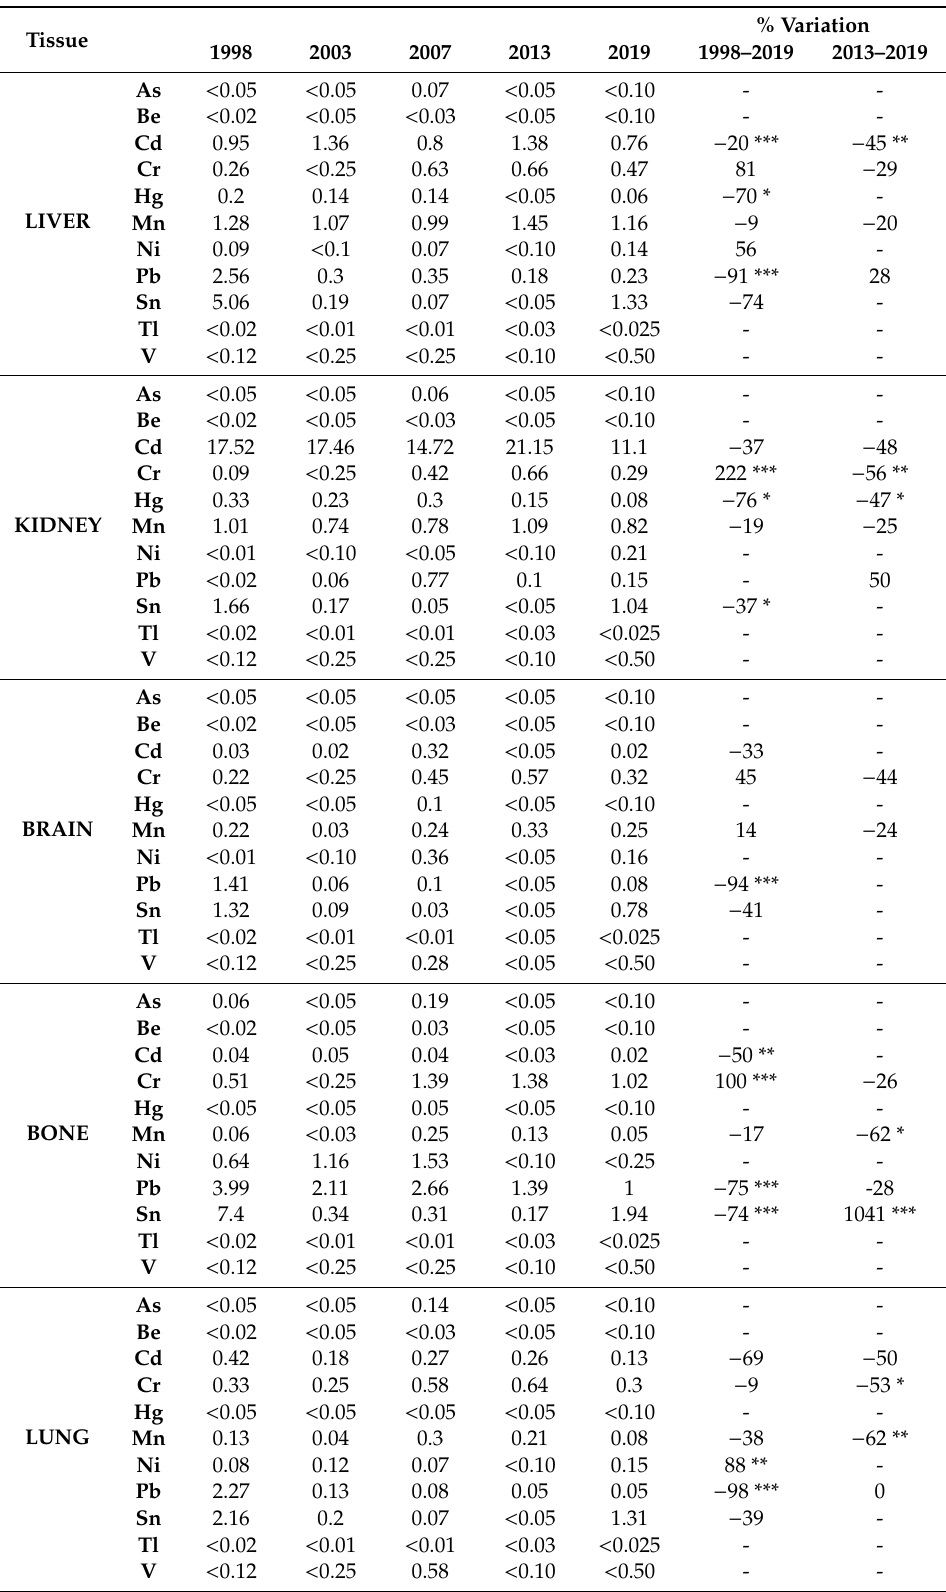
Table 2. Mean concentration ( µ g / g) of trace elements in autopsy tissues collected between 1998 and 2019. Temporal